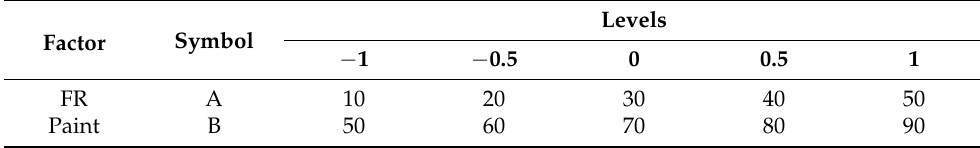
Table 1. Factors and levels used for the fire resistance test.